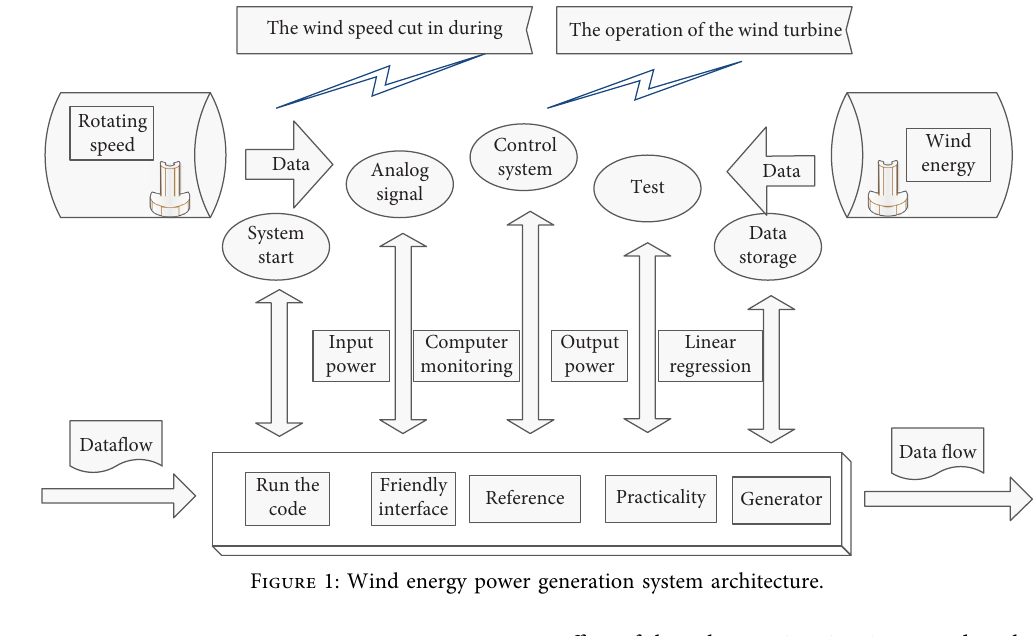
Figure 1: Wind energy power generation system